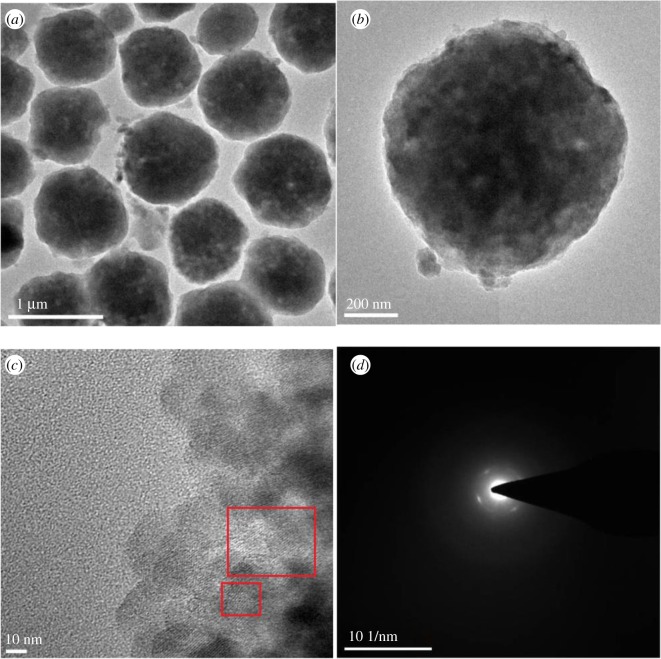
TEM images of TMZ-3.